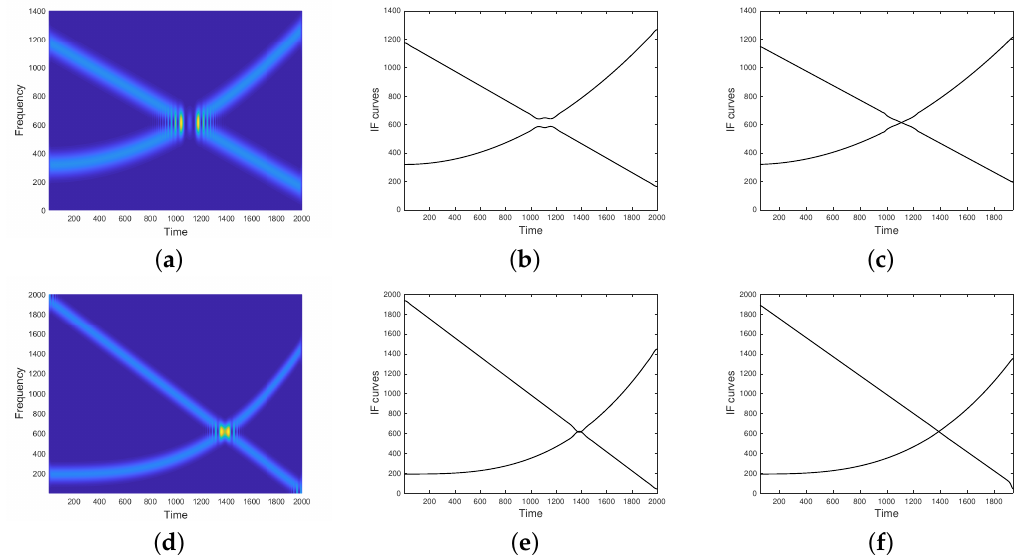
Figure 12. ( a ) Spectrogram of the two-component FM signal as in Equation (31) (destructive interference), ( b ) IF curves provided by the method proposed in [44] and ( c ) IF curves provided by the proposed method. ( d ) Spectrogram of the two-component signal as in Equation (32) (additive interference), ( e ) IF curves provided by the method proposed in [44] and ( f ) IF curves provided by the proposed method.